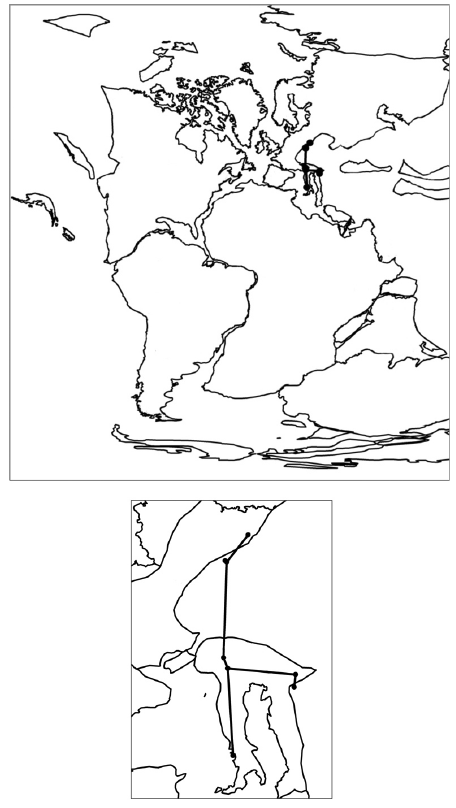
Fig. 1 - Ladinian paleogeographic map showing the individual track of Heptanema paradoxum , with a zoom of the occurrences